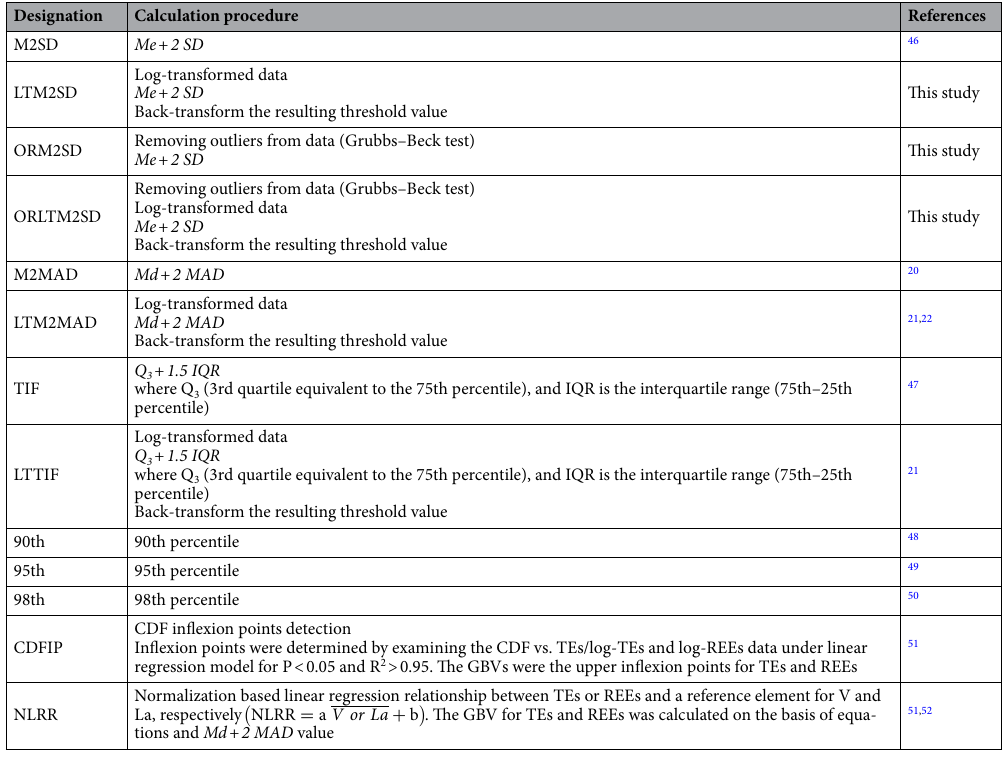
Normalization based linear regression relationship between TEs or REEs and a reference element for V and La, respectively (cid:31) NLRR = a V or La + b (cid:30) . The GBV for TEs and REEs was calculated on the basis of